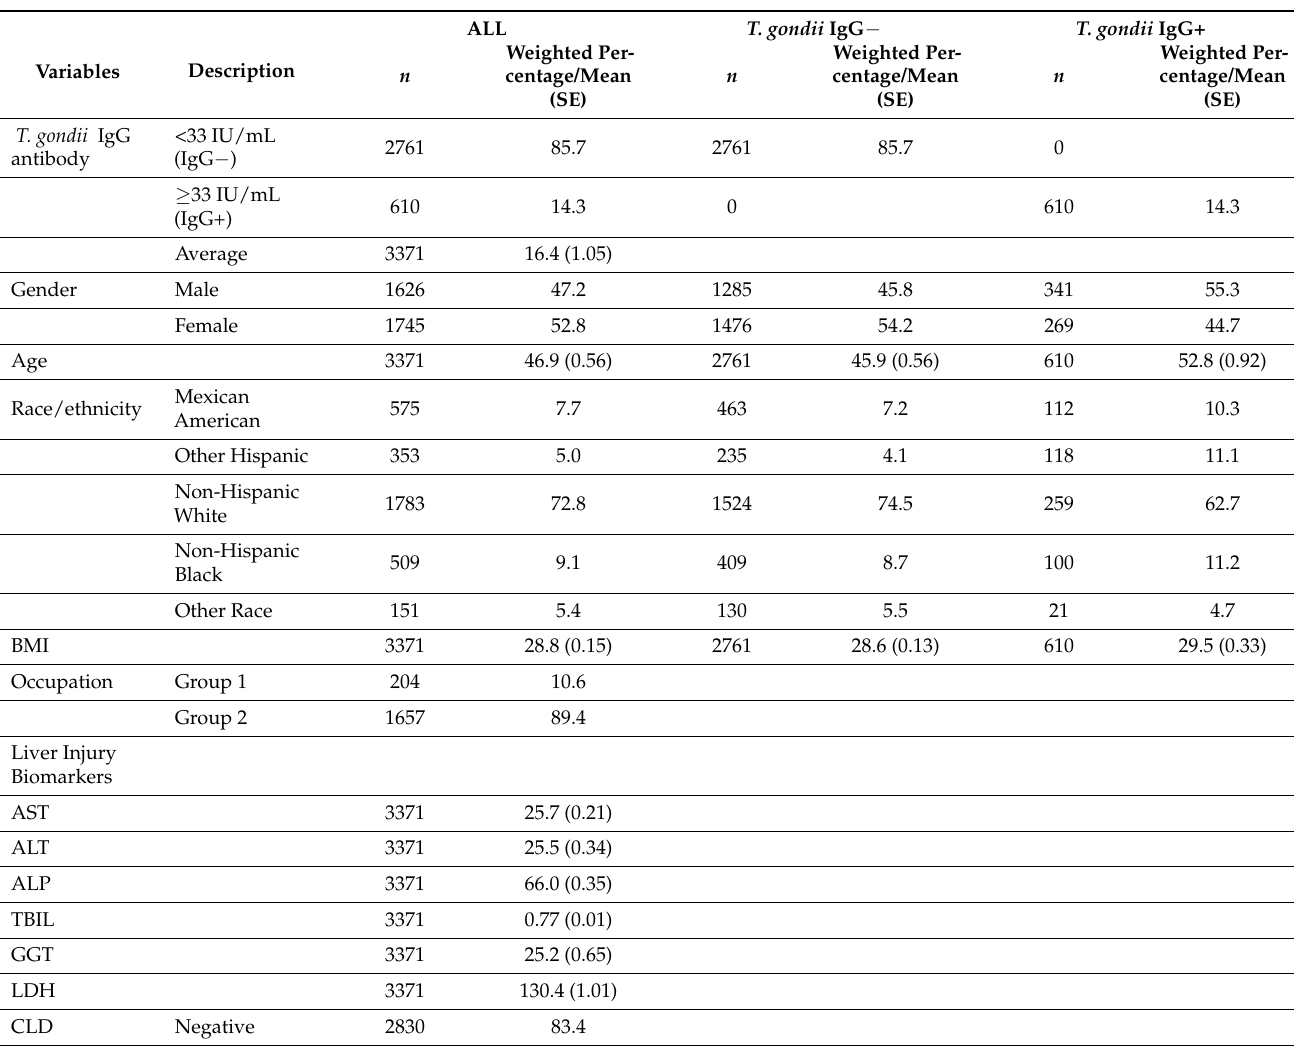
Table 1 provides summary statistics (survey-weighted percentages for categorical variables and survey-weighted means, and their corresponding standard errors, for quantitative variables) for the different variables used in the analysis. The sample consisted of 47.2% males and 52.8% females, with 14.3% of sample participants classified as T. gondii -positive (IgG+). The mean age of participants was 46.9 years, and 10.6% of participants worked in agriculture, forestry, fishing, mining, or in the construction occupation. The sample included Mexican Americans (7.7%), other Hispanics (5.0%), non-Hispanic whites (72.8%), non-Hispanic blacks (9.1%), and the other race category (5.4%). Table 1. Summary statistics for the characteristics of sample participants, n =